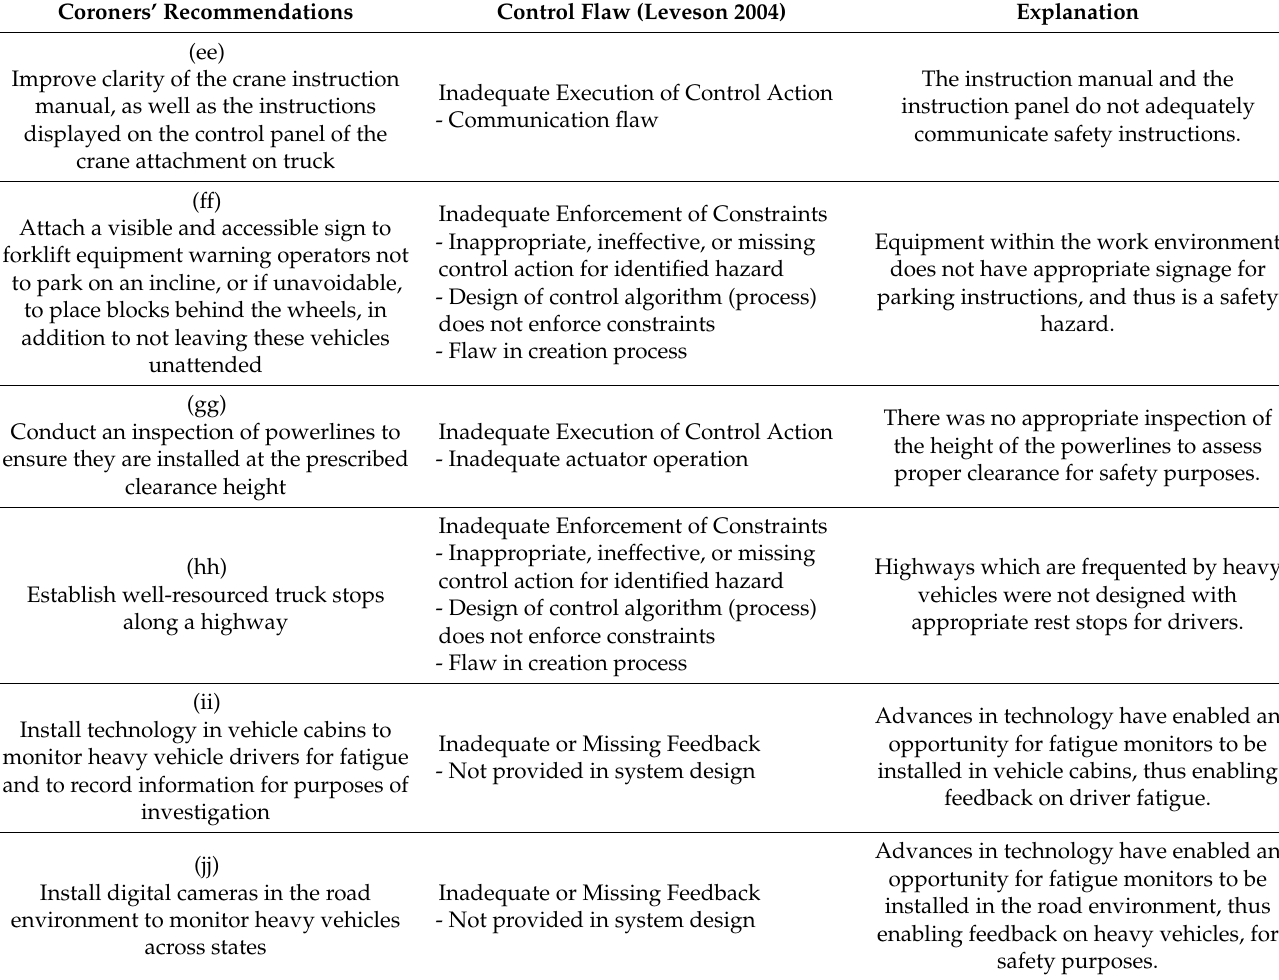
Table 10. Coroners’ Recommendations Mapped at STAMP Level 5—Operating Controller, Equipment, and Environment and Assigned to a Control Flaw (n =